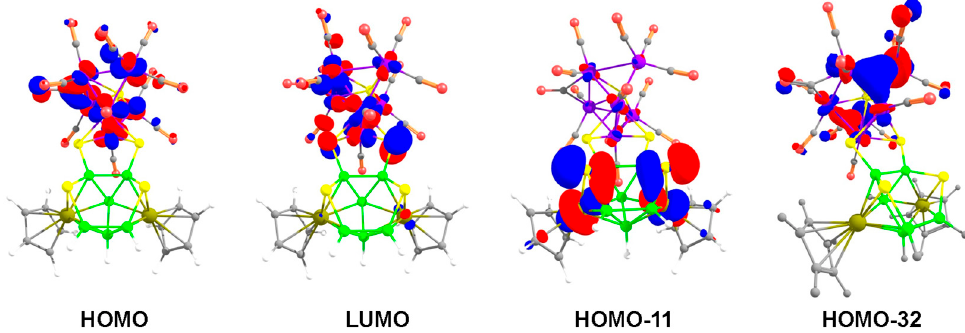
± 0.04 (e/bohr 3 ) 1/2 .